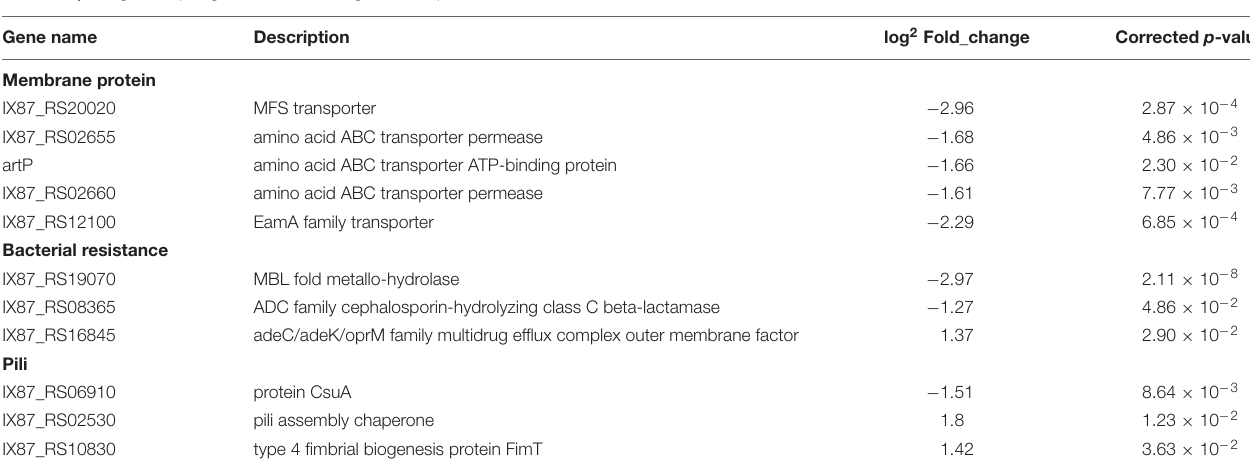
FIGURE 5 | (A) Venn diagram analysis of gene expression. The number in each circle represents the total number of genes that are expressed in each sample, and the overlapping part of circles indicates that the gene is co-expressed in both samples. (B) The volcano plots of the differentially expressed genes. Significantly differentially expressed genes were treated with red dots (up-regulated) or green dots (down-regulated). The abscissa represents fold change, and the ordinate represents statistical significance. TABLE 1 | The genes up-regulated or down-regulated response to